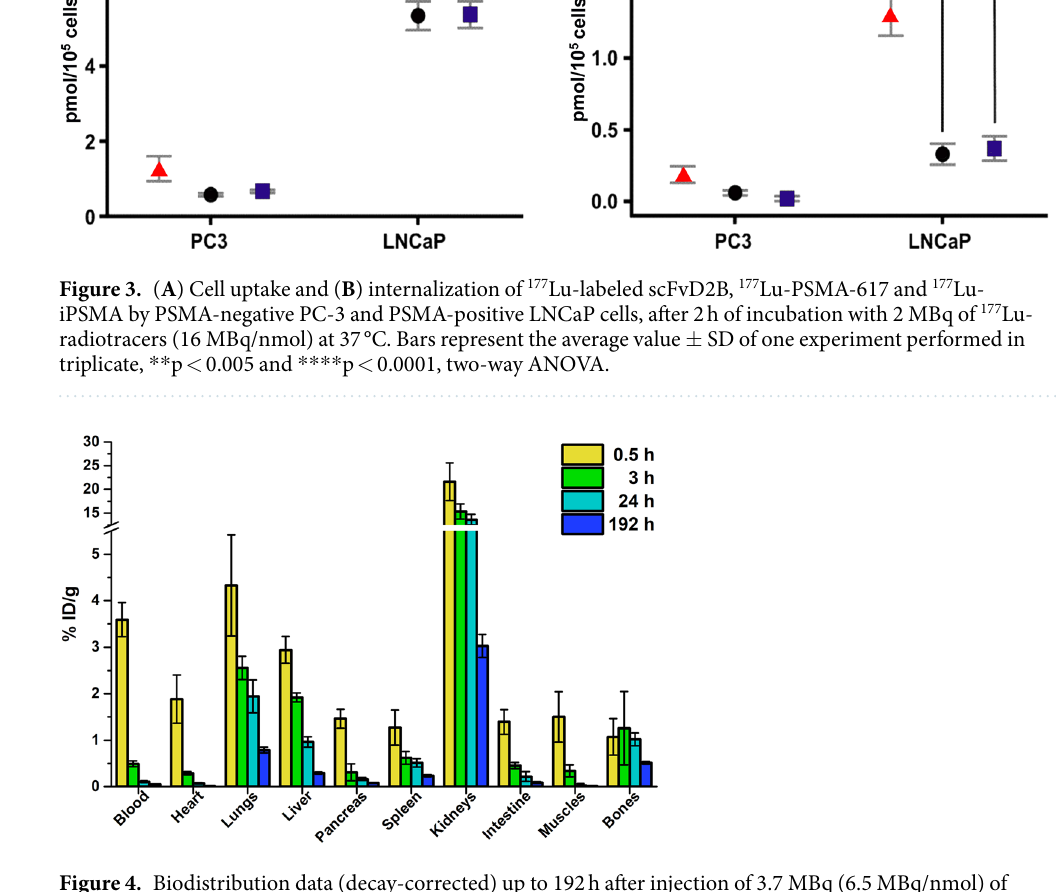
Figure 4. Biodistribution data (decay-corrected) up to 192 h after injection of 3.7 MBq (6.5 MBq/nmol) of 177 Lu-scFvD2B in healthy nude male mice, and expressed as %ID/g. Bars represent the average value ± SD obtained from each group of mice (n =